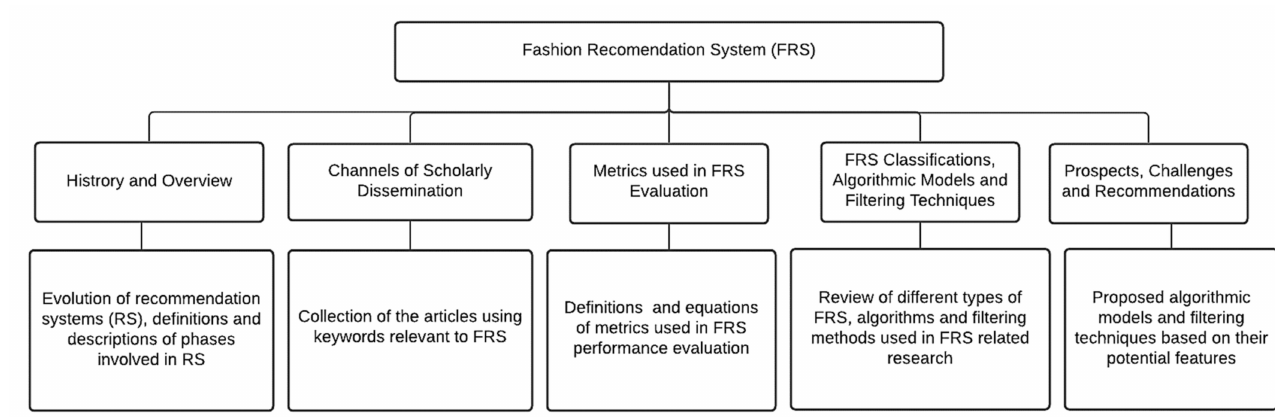
Figure 1. Organizational structure of the article.